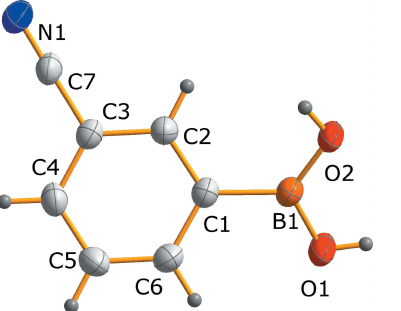
Figure 2 The molecular structure of the title compound (I), with the atom labeling. Displacement ellipsoids are drawn at the 50% probability level.